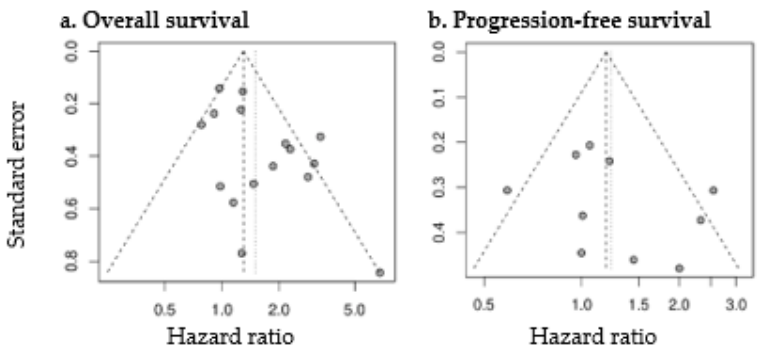
Figure 5. Funnel plots of studies assessing the prognostic value of SUV max for OS ( a ) and PFS ( b ).